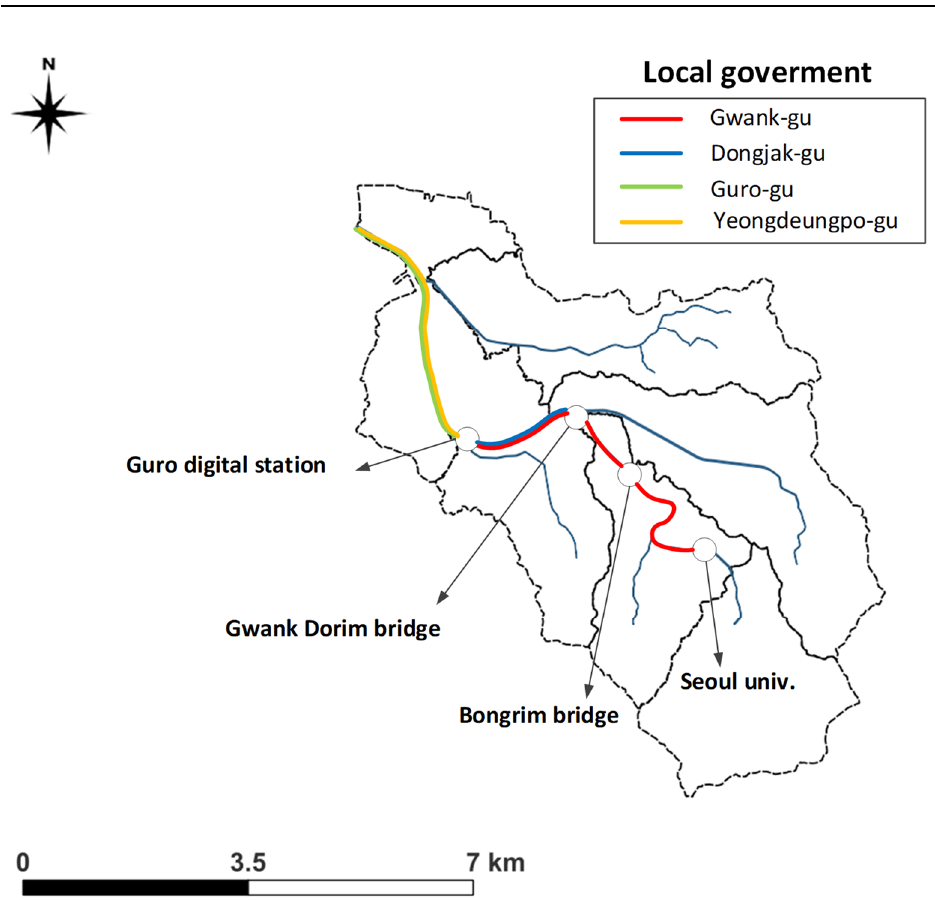
Figure 8. Flood defense locations according to local governments.